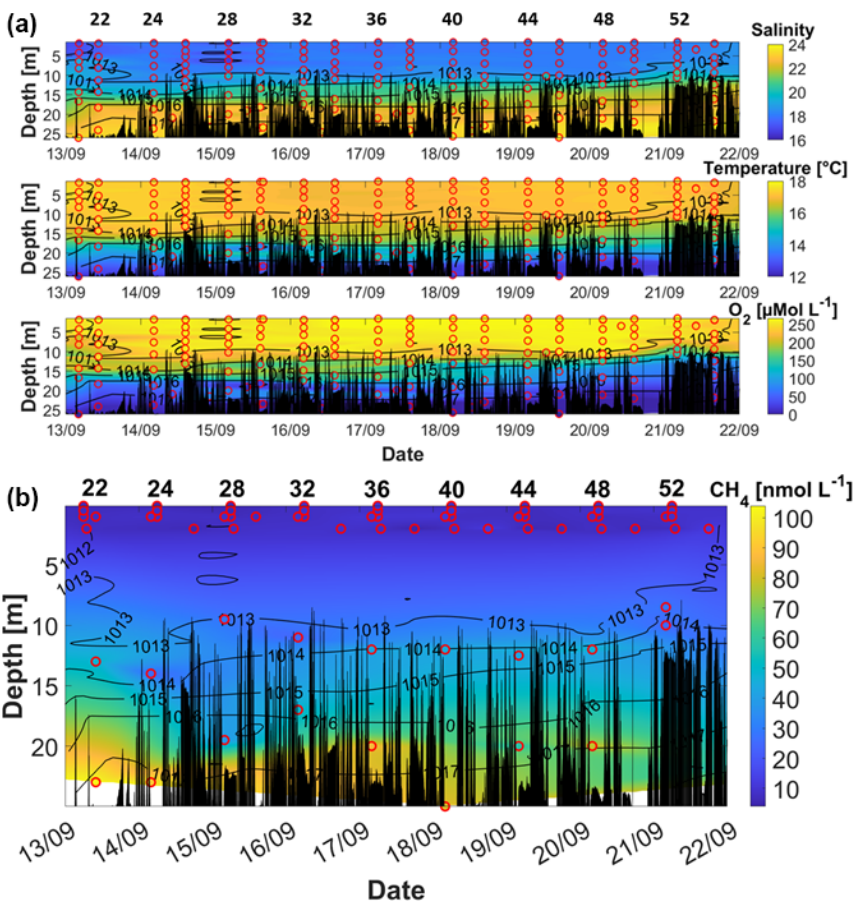
Figure 5. (a) Salinity (upper sub-panel), temperature (middle sub-panel), and O 2 (lower sub-panel) during September 2018. (b) CH 4 con- centrations in September. Red circles mark the location of the discrete measurements. Black peaks show the topography along the cruise track. Contour lines represent the density. The station numbers refer to those in figure